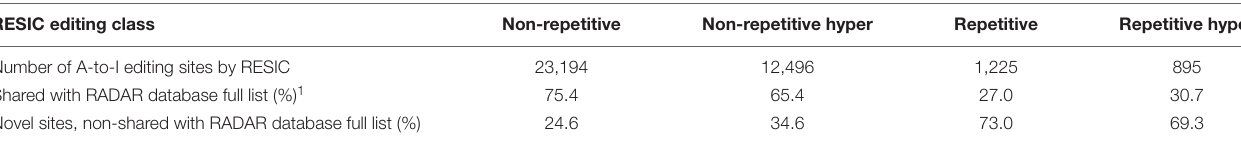
TABLE 1 | Overlap levels of the detected A-to-I editing sites with RADAR